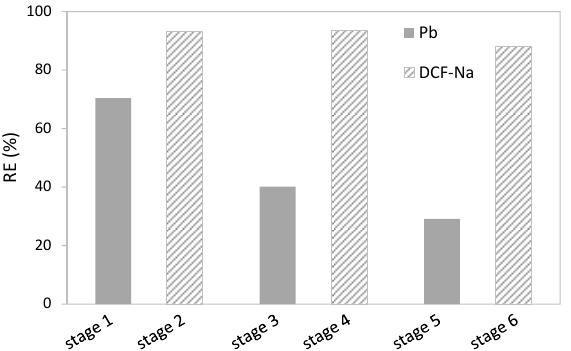
Figure 9. Removal e ffi ciency (RE) of the pollutants in consecutive adsorption-desorption cycles.